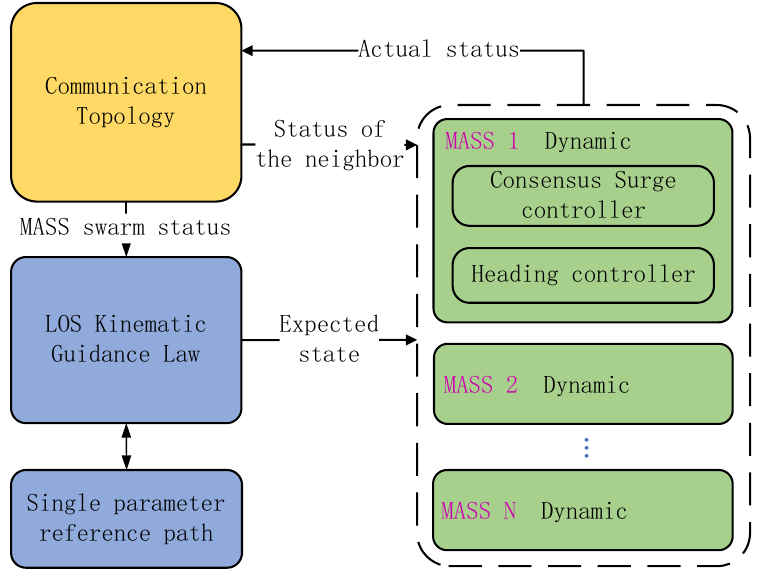
Figure 1. Cooperative path tracking structure of a swarm of MASSs.